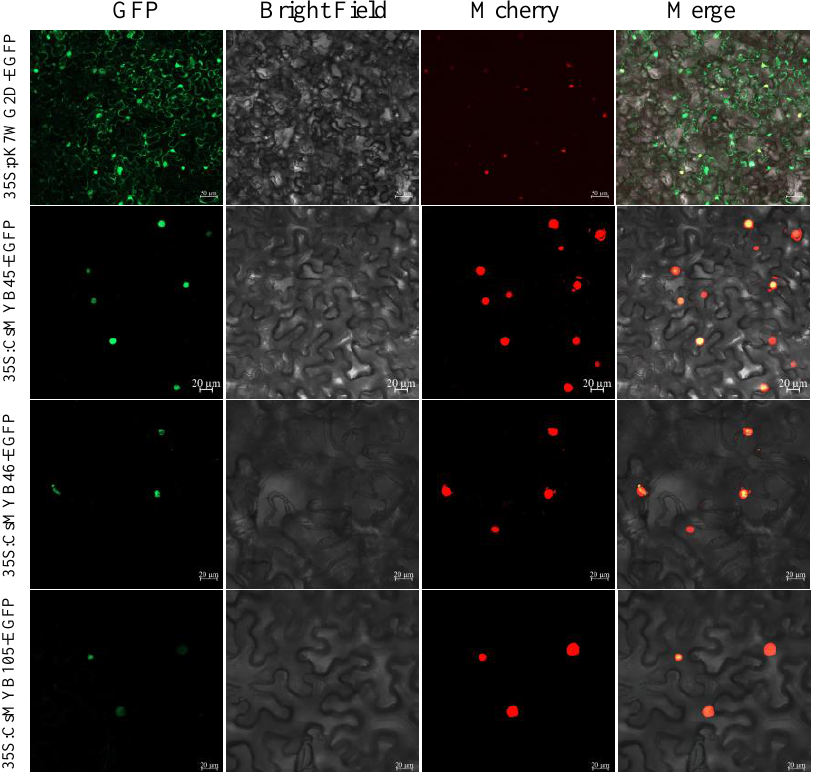
Figure 3. Subcellular localization of the fusion proteins 35S:: CsMYB45 ::EGFP, 35S:: CsMYB46 ::EGFP, and 35S:: CsMYB105 ::EGFP expressed in tobacco epidermal cells by transient infiltration. The 35S::EGFP vector was used as the control, and P19 − mCherry was used as a nuclear marker. Images are representative of at least three replicate experiments. Bar = 20 µm.